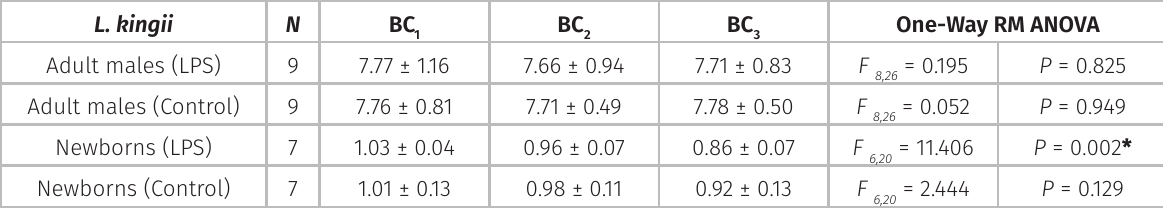
), right before (BC 1